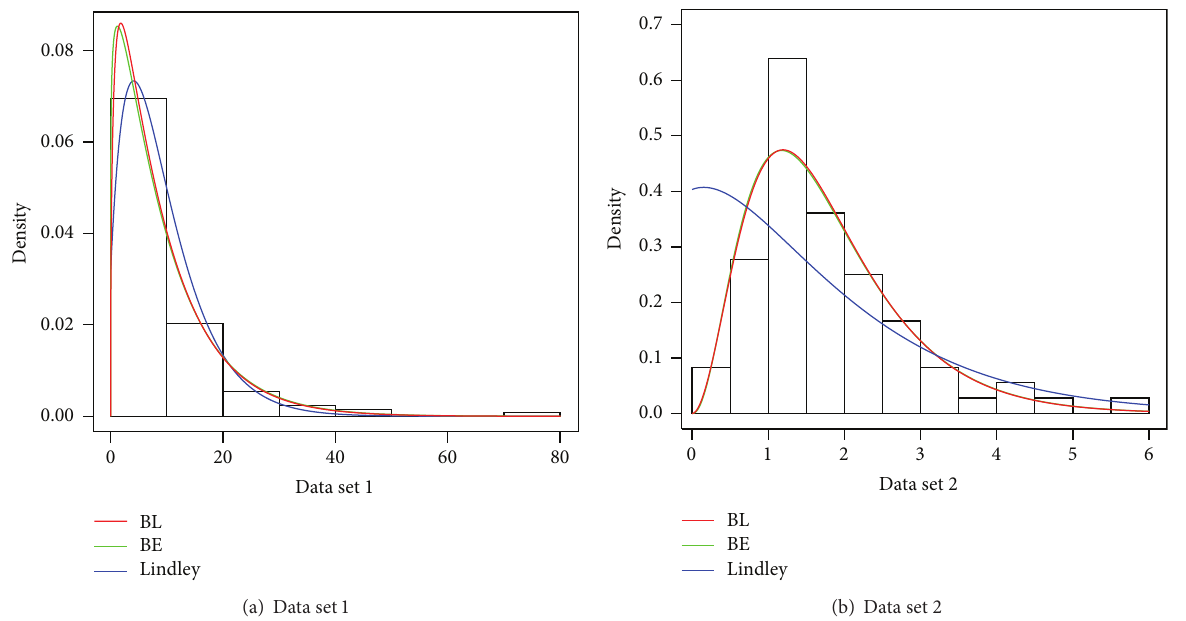
Figure 2: Estimated densities of the models for data set